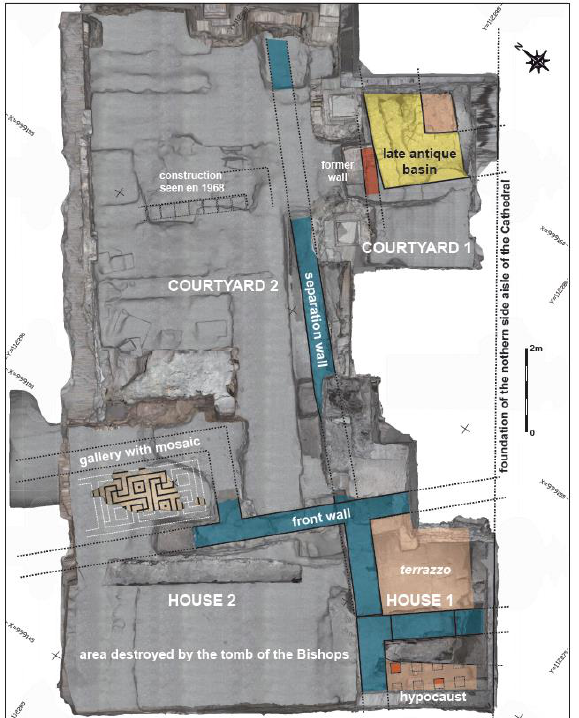
Figure 11. Map of the basement, produced from the 3D textured model of the St. Lawrence Chapel with indication of the ancient remains (late antique basin discovered this year).